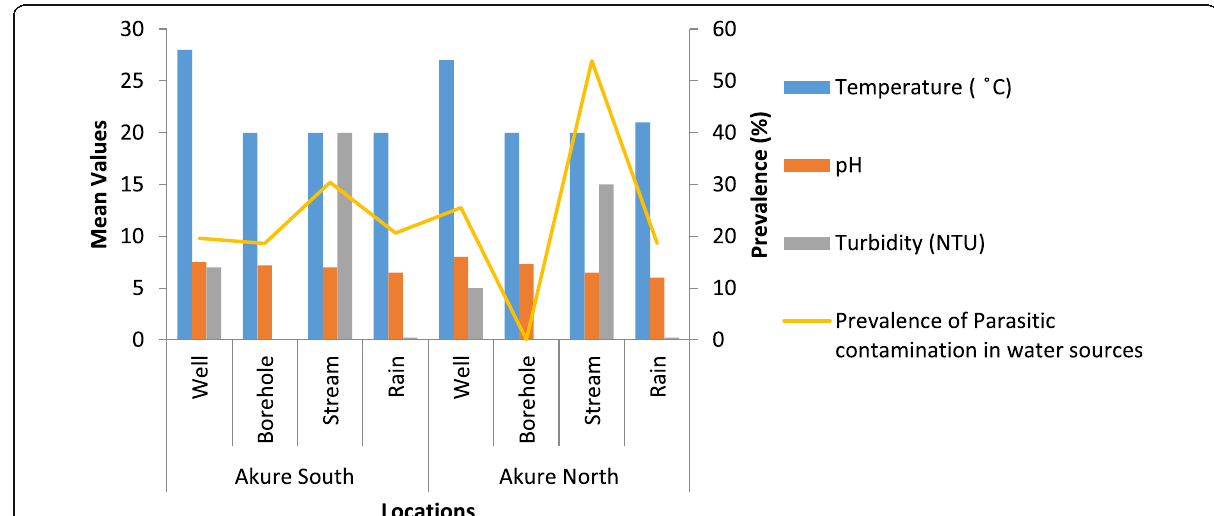
Fig. 2 Water parameters in relation to the occurrence of parasite in water sources. Statistical analysis showed significant difference in the different water parameters (p < 0.05)